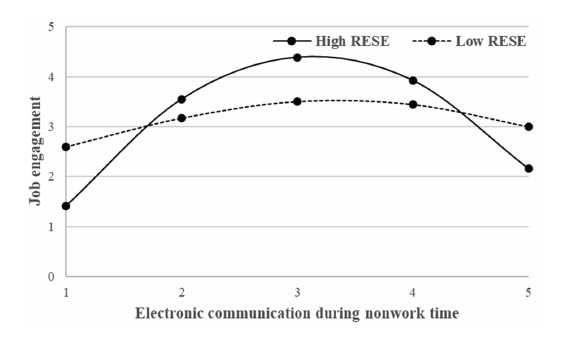
FIGURE 4 The moderating effect of regulatory emotional self-efficacy.